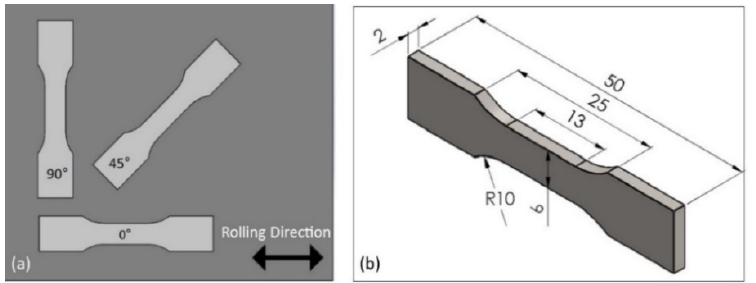
Figure 2. (a) Dog-bone sample orientation for the wrought alloy and ( b ) dimensions for all samples (in mm).